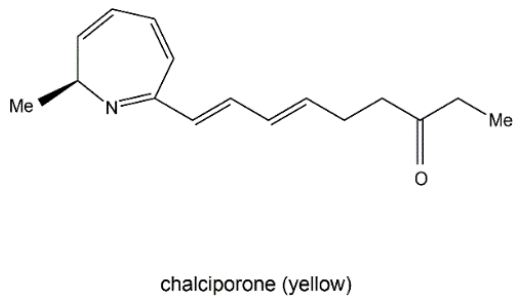
Figure 9. Chalciporone.